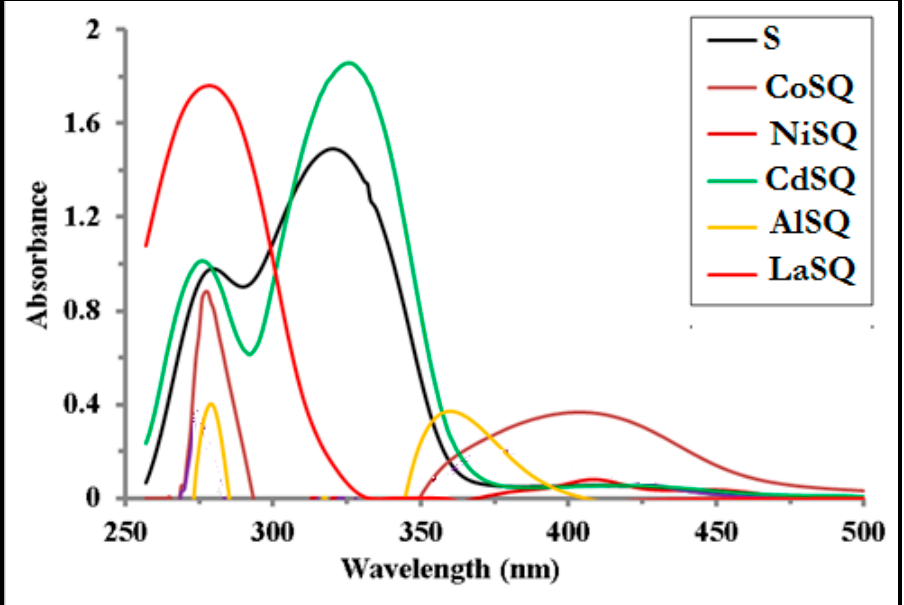
Figure 3. Electronic spectra of the synthesized Co(II), Ni(II), Cd(II), Al(III), and La(III) metal com- plexes of salen/8-hydroxy quinoline in DMSO with concentration 10 − 3 M at 298 K.